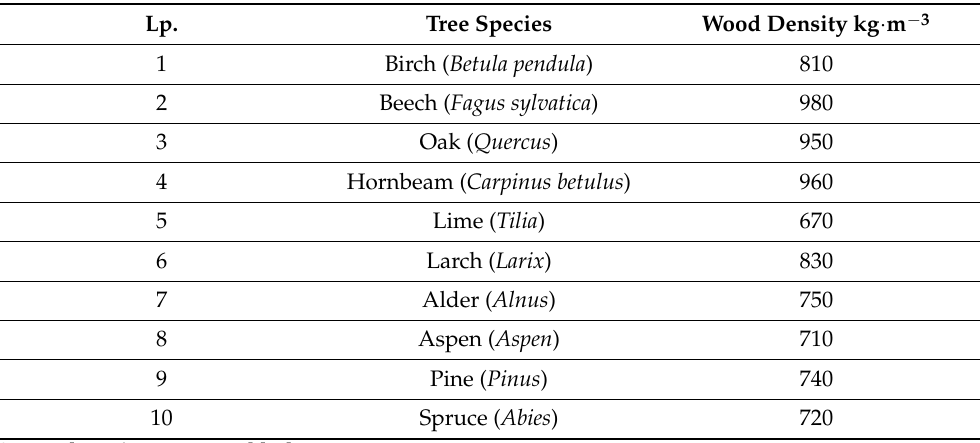
Table 2. Normative wood densities of selected species. Lp. Tree